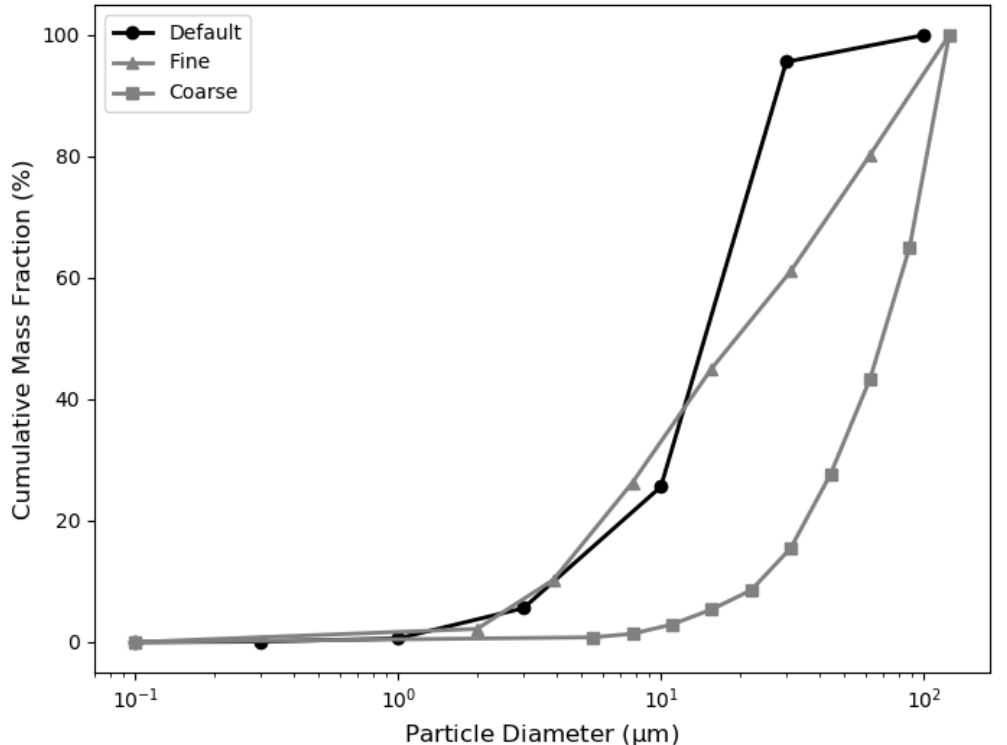
Figure 4. The PSD options available to the London VAAC operational meteorologists. The default is based on airborne measurements of the ash cloud from Mount Redoubt in 1990 [45], the Coarse PSD is based on sampling of deposits from the eruption of Hekla in 1991 [94], and the Fine PSD is from deposit sampling and satellite retrievals of the ash from the eruption of Eyjafjallajökull in 2010